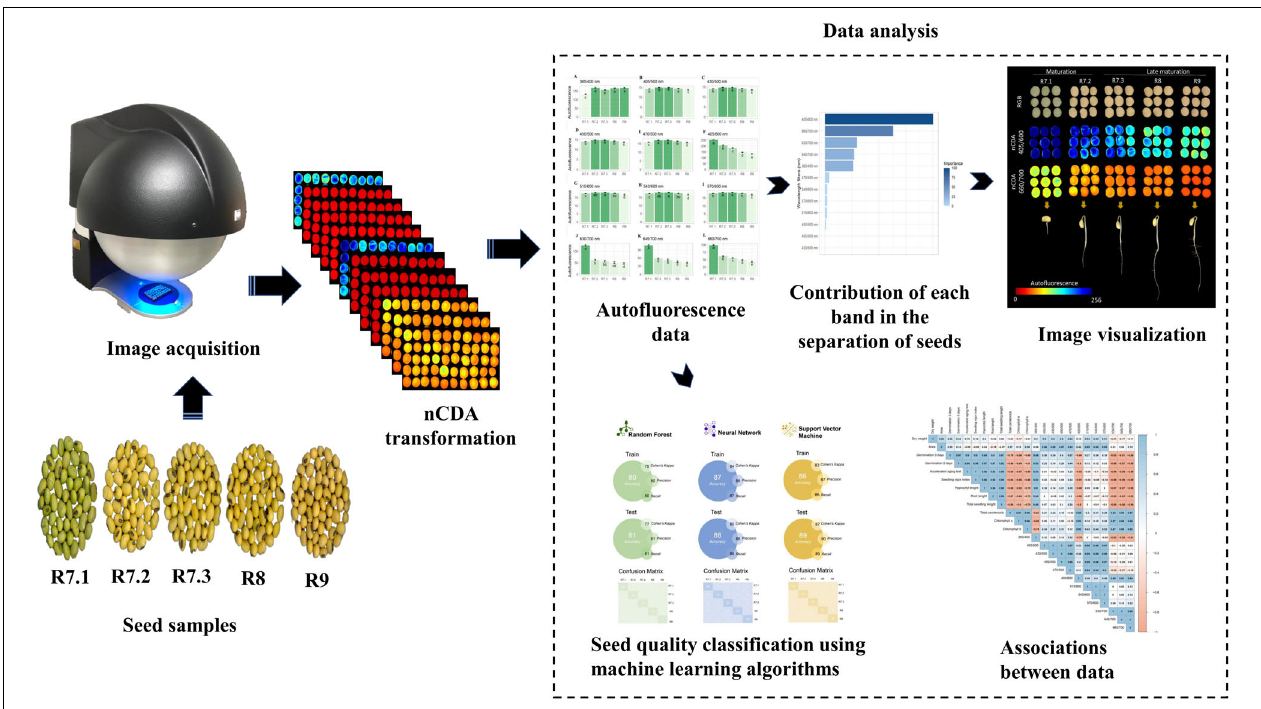
FIGURE 1 | Flowchart of the main steps to classify the maturation stages of soybean seeds based on autofluorescence-spectral imaging combined with machine learning algorithms.